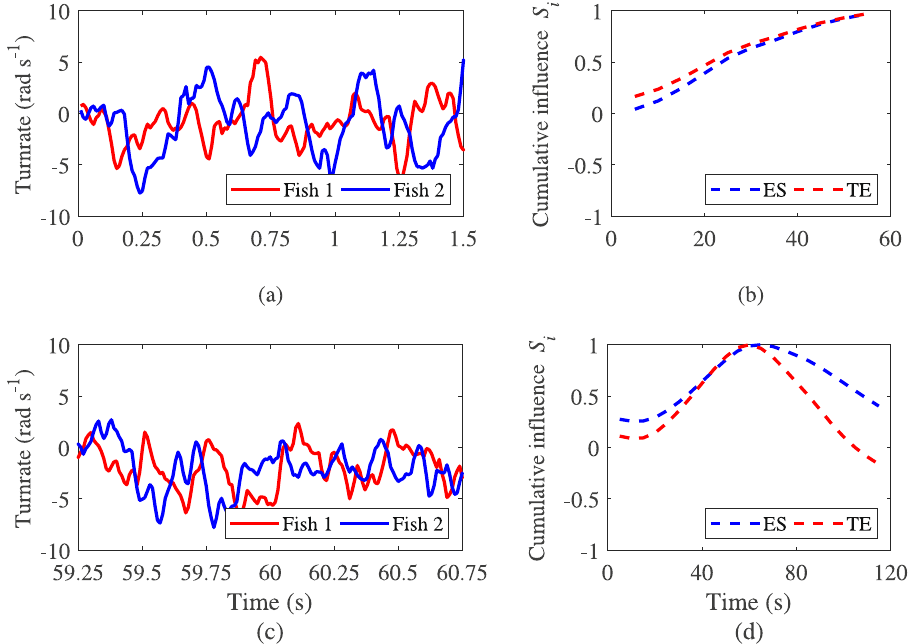
Figure 9. Illustration of the time trace of a sample fish turnrate and of the cumulative influence of fish 1 in the absence and in the presence of a switching leadership event. The figure depicts the evolution of the turnrate and the resulting effect on the cumulative influence index as time evolves. Turnrate time trace is limited to facilitate the visualization of the times series. Note that the values of the cumulative influence S i are normalized between − 1 and 1. Model parameters for the simulations are summarized in Supplementary Information Table S2.